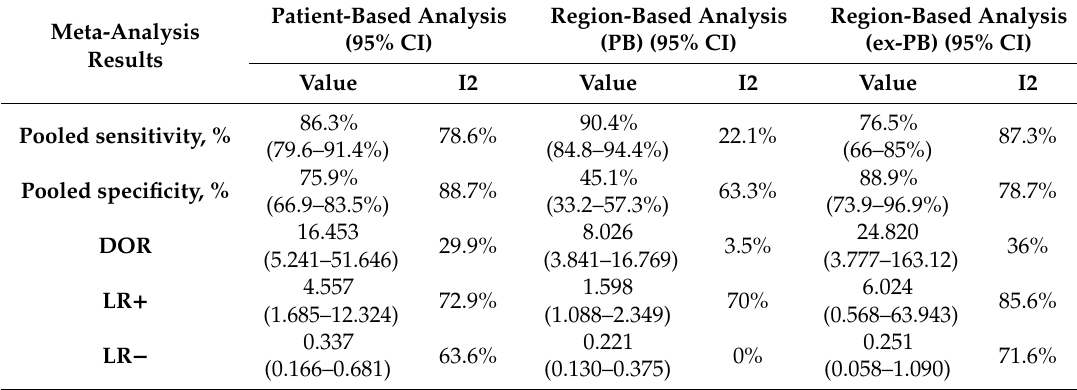
Table 4. The pooled diagnostic performance for 18 F-FACBC (independently from the clinical setting and